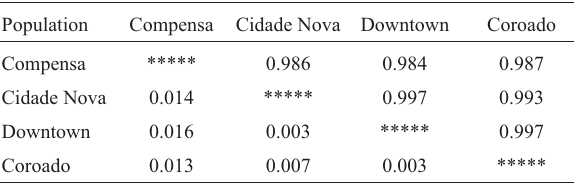
Table 5 - Matrix of genetic distance and similarity among the four Aedes aegypti populations.